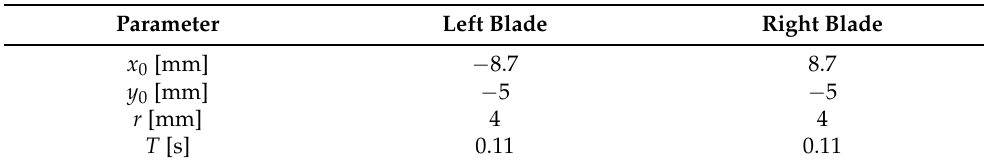
Table 4. Numerical values used in the design of the blades. Parameter Left Blade Right Blade x 0